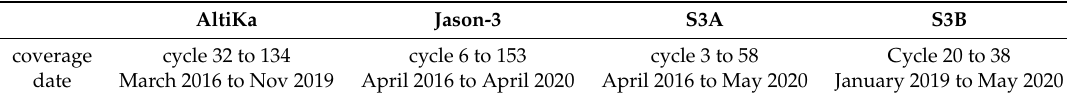
Table 4. Data coverage for crossover and variance of Sea Surface Height (SSH)